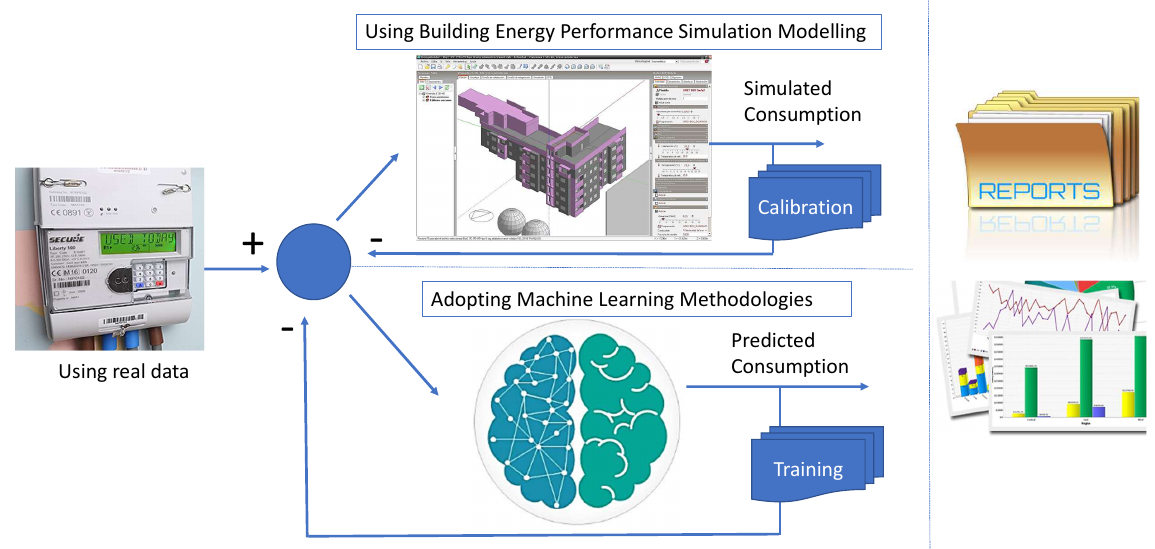
Figure 1. Comparing paradigms related to building energy performance simulation tools and machine learning